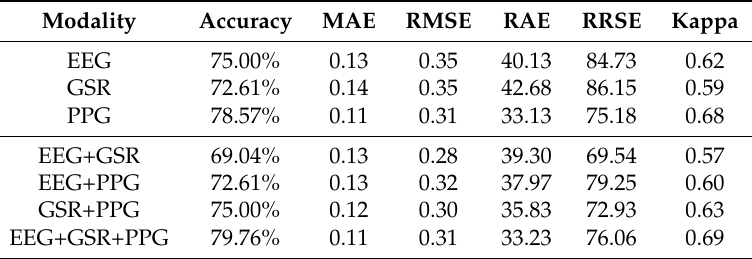
Table 4. Classification performance for emotion recognition using EEG, GSR, PPG, and modality level fusion in response to TEM content.